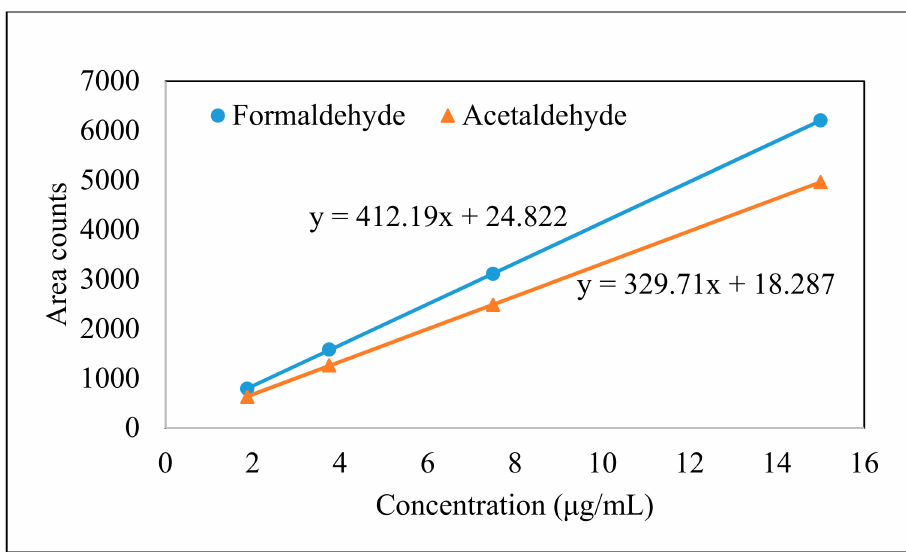
Figure 6. Calibration between area and two aldehyde concentrations of standard